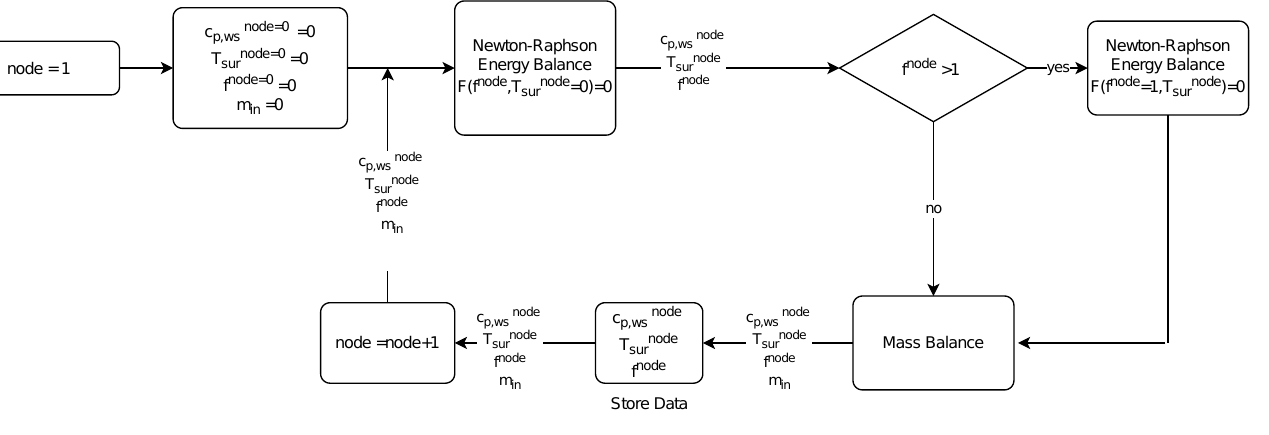
Figure 5. Algorithm resolution scheme.